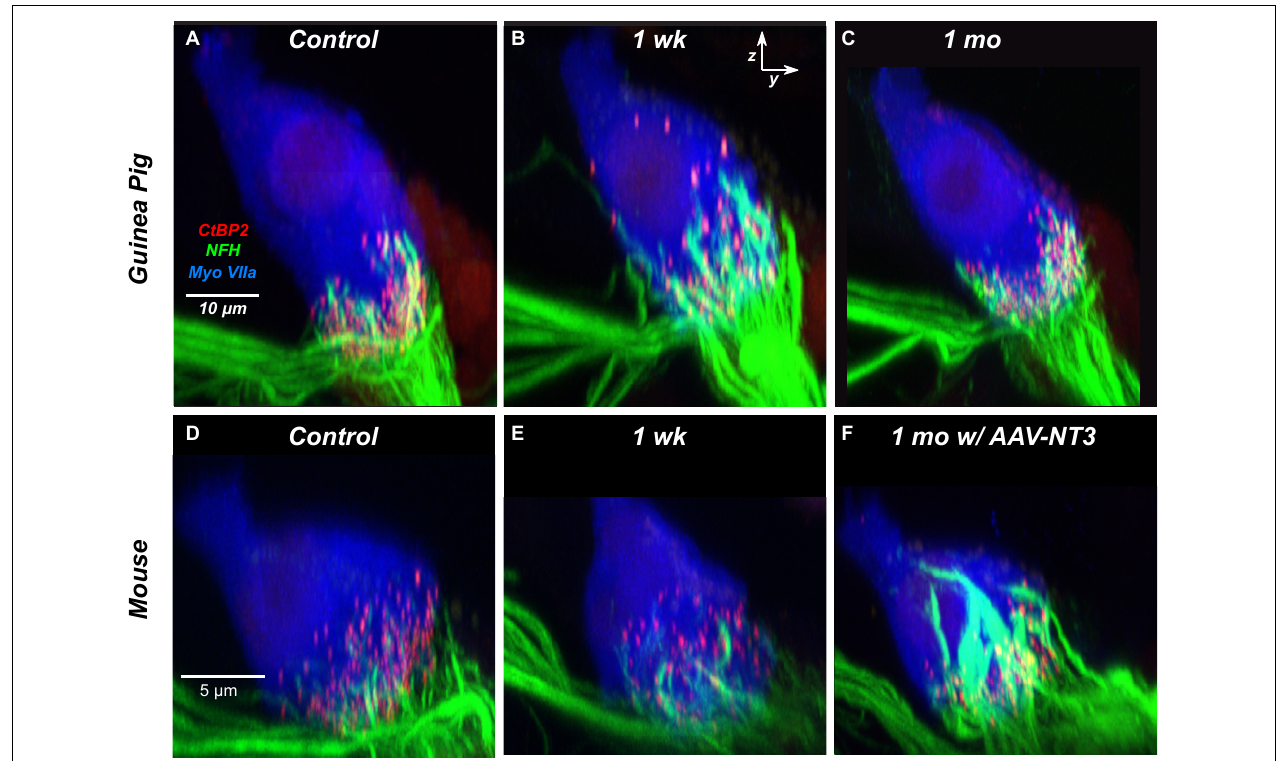
FIGURE 12 | The neurite extension seen spontaneously in the noise-exposed guinea pig (B) has a similar morphology to the neurite extension seen in mouse ears treated with virally mediated NT3 overexpression, both exposed (F) and unexposed (not shown). Panels (A–C) are from the 22.6 kHz region and are taken from a prior study of noise-induced synaptopathy in juvenile guinea pigs (Hickman et al., 2020). Panels (D–F) are from the 32 kHz region and are taken from a prior study of noise-induced synaptopathy in CBA/CaJ mice pre-treated with AAV virus particles carrying an NT3 gene sequence (Hashimoto et al., 2019). Panels (A,D) are from unexposed controls; panels (B,C,E,F) are from exposed animals at the survival times indicated. All images are zy projections of confocal z-stacks, all very similar in xy field of view to the projections shown in Figures 6A,B